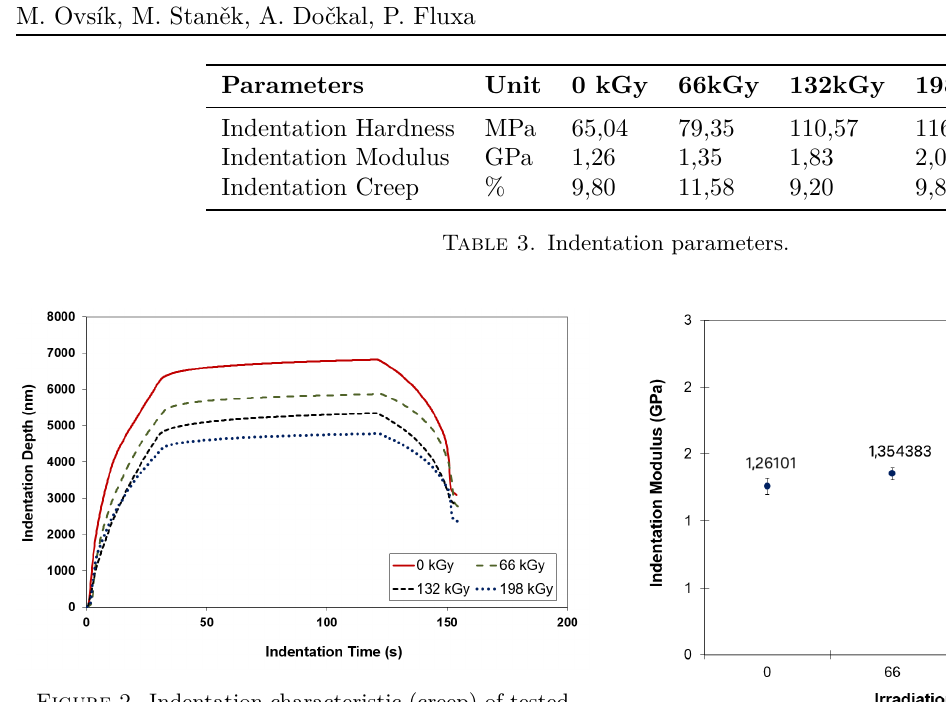
Figure 2. Indentation characteristic (creep) of tested PBT 35%GF.